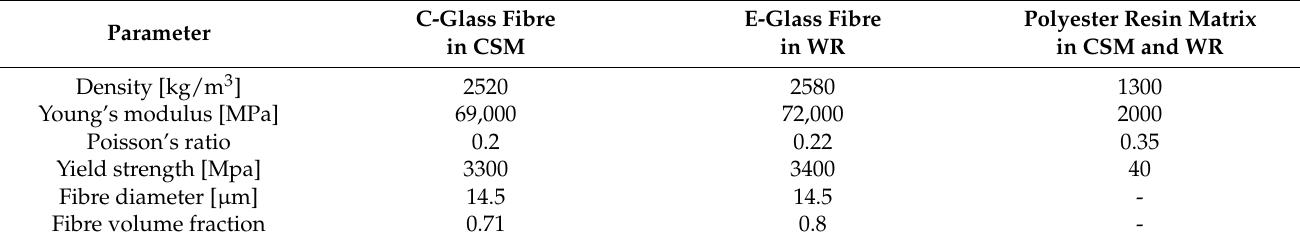
Table 2. Material parameters in the micro-scale RVE